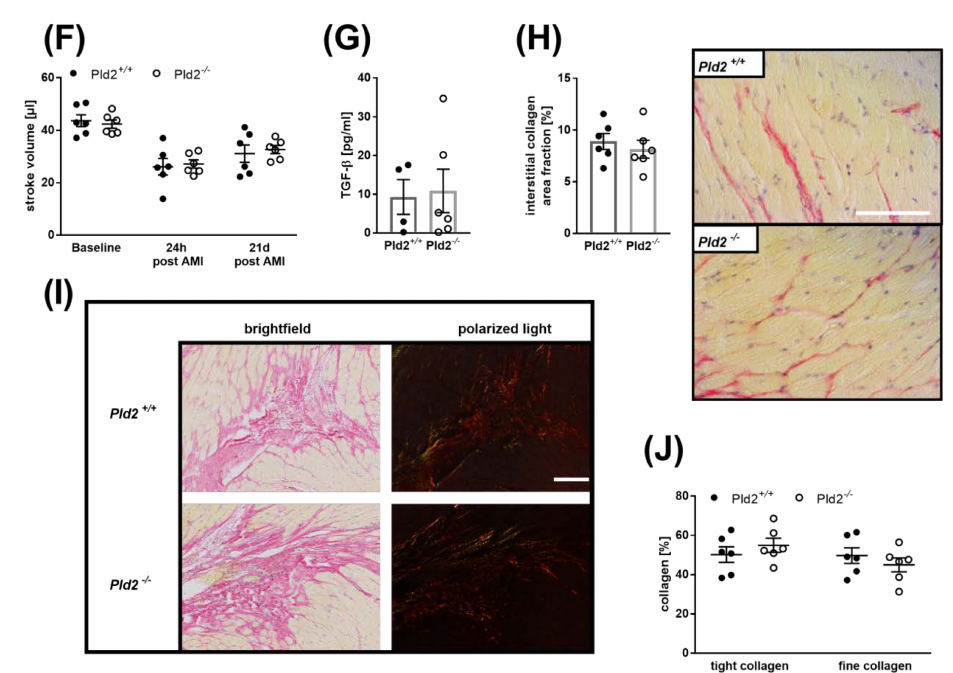
Figure 6. Unaltered scar formation and cardiac remodeling 21 d post MI in Pld2 − / − mice. ( A ) Quantification of the infarct zone as percentage of the left ventricle in transversal cardiac sections stained with Gomori’s step one trichrome, n = 6. ( B ) Representative images are shown. Scale bar 1 mm. ( C–F ) Echocardiographic analysis (baseline versus 24 h and 21 days after I / R) of ( C ) ejection fraction, ( D ) cardiac output, ( E ) fractional shortening and ( F ) stroke volume, n = 6. ( G ) Quantitative analysis of TGF- β in plasma 21 days after I / R, n = 4–6. ( H–J ) Cardiac sections were stained with Sirius red 21 d after I / R to analyze ( H ) the amount of interstitial collagen at the infarct border zone and ( I–J ) the quality of collagen in the infarct zone of the left ventricle as marker of cardiac remodeling, n = 6. Representative images are shown ( H and I , scale bar 100 µ m). Bar graphs depict mean values ± SEM. Statistical analysis was performed using a two-tailed Student’s t -test. AMI = acute myocardial